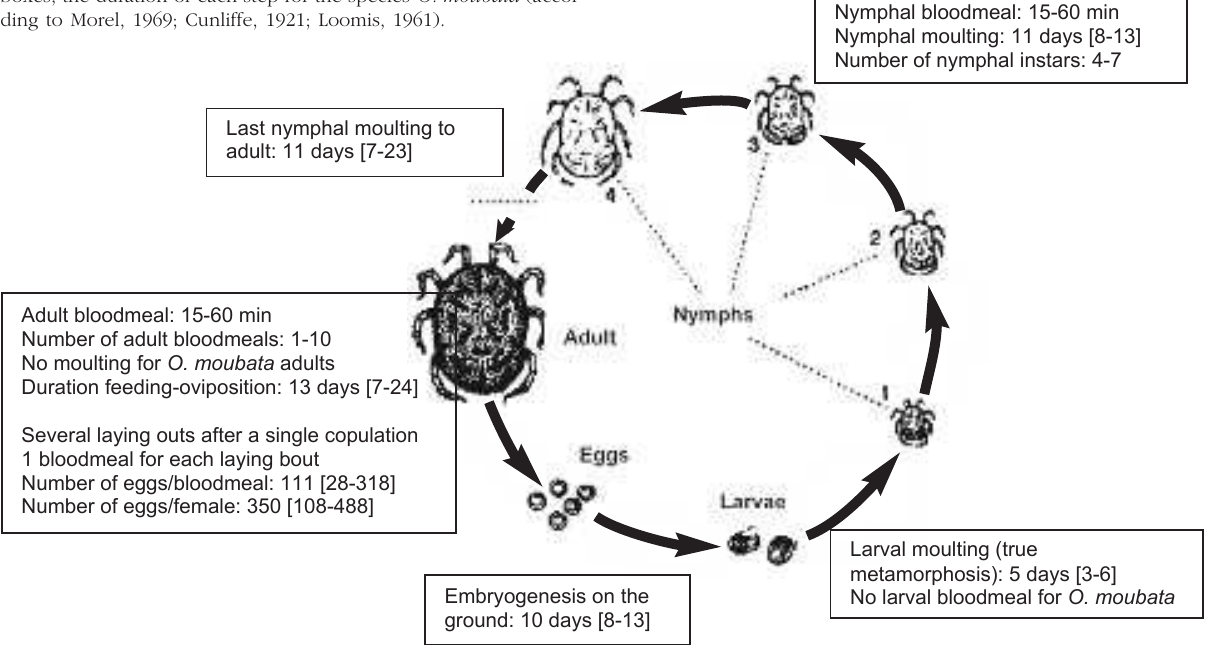
Fig. 2. – A typical life-cycle of a soft tick indicating the different deve- lopmental instars, the crucial steps between instars and, in grey boxes, the duration of each step for the species O. moubata (accor- ding to Morel, 1969; Cunliffe, 1921; Loomis,